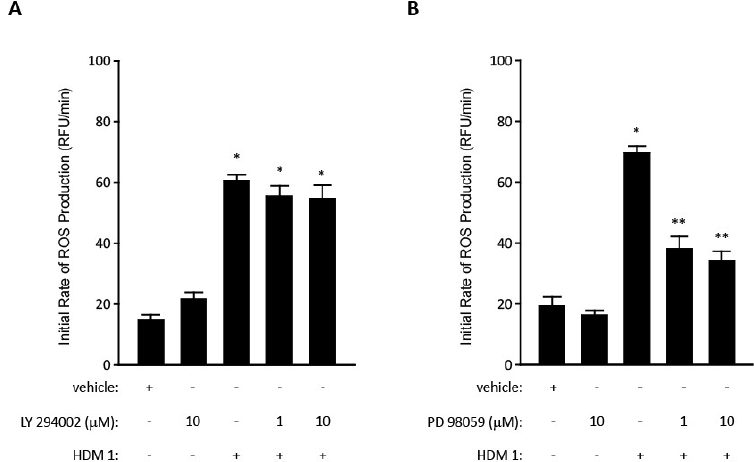
Figure 3. Mechanisms of signalling crosstalk between GPCRs and EGFR (Abbreviations: GPCR, G-protein coupled receptor; PI 3-kinase, phosphoinositide 3-kinase, PDK 1, phosphoinositide-dependent protein kinase 1; src, proto-oncogene tyrosine-protein kinase src; ADAM, a disintegrin and metalloprotease; EGF/EGFR, epidermal growth factor/receptor). Blue arrows denote initial agonist-receptor interaction and the signals derived directly or indirectly from it. Grey arrows denote intracellular signalling events involved in crosstalk. Red arrows denote extracellular signaling crosstalk.